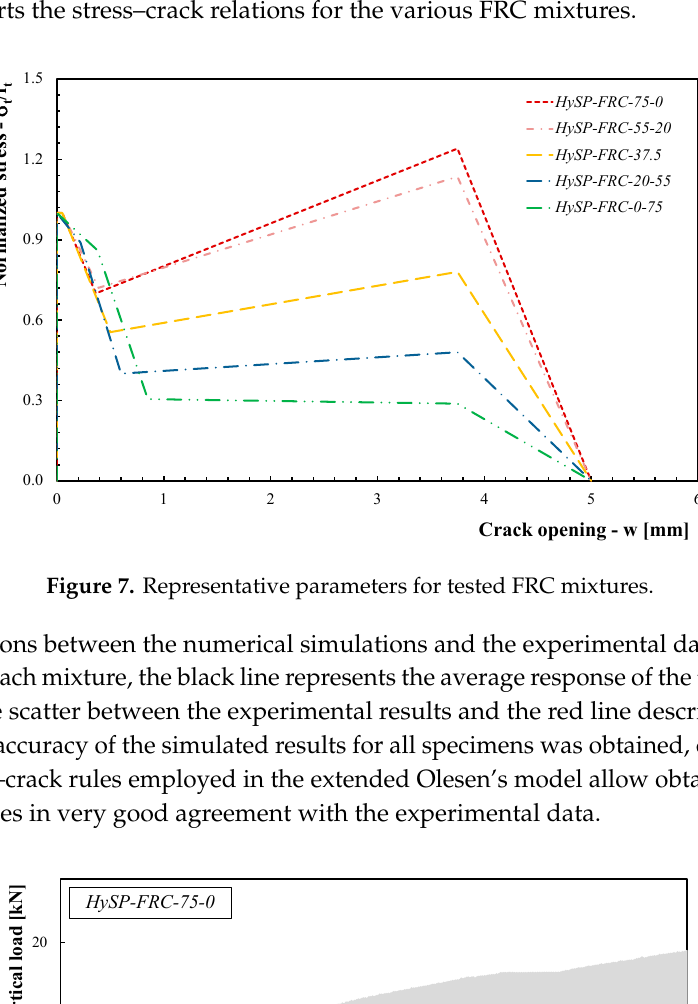
Figure 9. Experimental and numerical load–CMOD curves for the HySP-FRC-55-20 mixture. Figure 10. Experimental and numerical load–CMOD curves for the HySP-FRC-37.5 mixture.